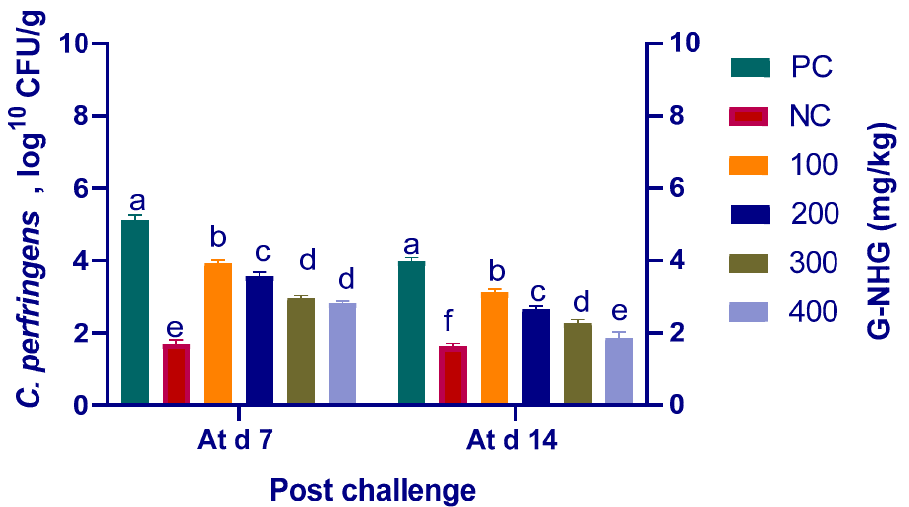
Figure 5. Impact of dietary supplementation of various levels of G-NHG on C. perfringens population in ileal digesta of broiler chickens at 7 and 14 d post challenge. Values are means with their SE in bars. PC (positive control): birds fed a basal diet and challenged with C. perfringens, NC (negative control): birds fed a basal diet, G-NHG (100, 200, 300 or 400 mg/kg)-treated groups: birds fed a basal diet supplemented with 100, 200, 300 or 400 mg/kg of garlic nanohydrogel and challenged with C. perfringens . a–f Means within the same column carrying different superscripts are significantly different at p < 0.05. Table 6. Economical parameters of broiler chickens fed various levels of G-NHG and challenged with C. perfringens. Group G-NHG, mg/kg PC NC SEM Parameter